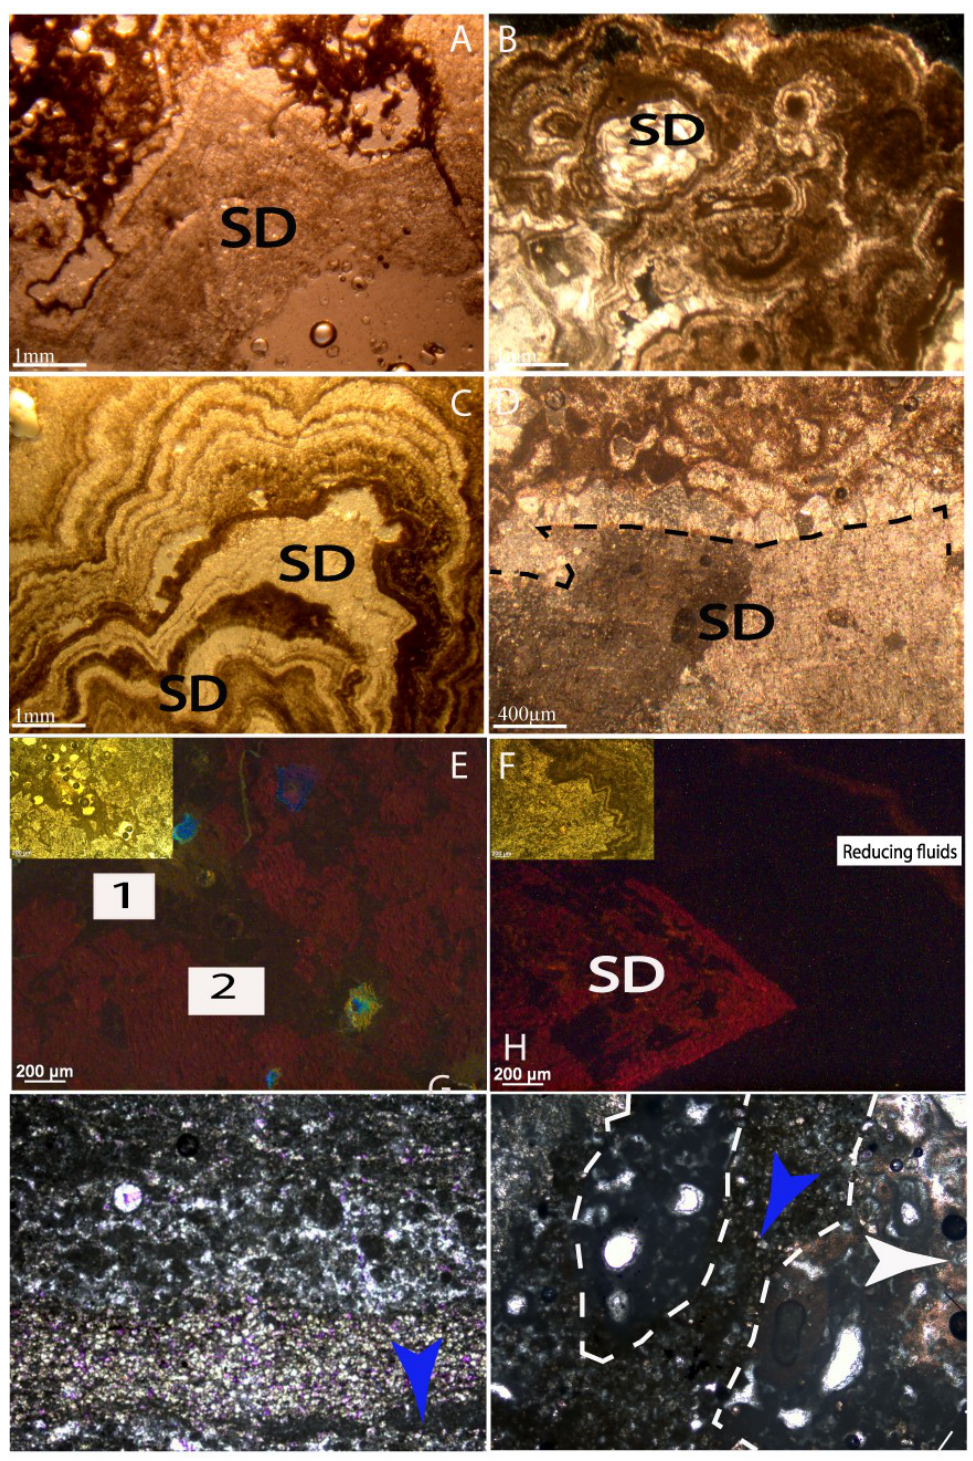
Figure 11. ( A – H ) Photomicrographs of calcrete products and tidal features. ( A ) Thin section, plane light; dirty saddle dolomite crystal (SD) penetrated by the alveolar texture (Av), followed by bladed cementation (white arrows) due to meteoric / vadose fluids (see text). Spelek section. ( B ) Thin section, plane polarized light; showing the pisolitic texture, where pisoids are spherical or irregular, and their nuclei are composed of saddle dolomite (SD) of former hydrothermal products (see text). Concentric laminated layers enclose the pisoids, and the space between the layers is filled by fibrous cement. Middle lower part of photo shows a clear bladed cement (BL) along the laminated layer. Spelek